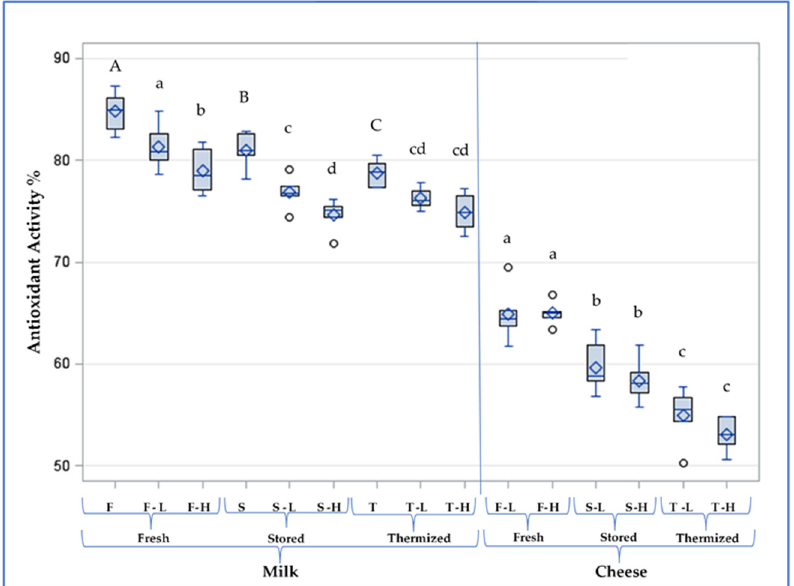
Figure 6. Comparison of antioxidant activity in milk before pasteurization and after low and high pasteurization, and in the corresponding cheese made from each type of milk. Different letters indicate significant differences ( p < 0.05) within the group of milk or cheese. For the milk group, different capital letters were used in milk before pasteurization (F, S, and T) while lowercase letters in milk after pasteurization (F-L, F-H, S-L, S-H, T-L, T-H). Milk before pasteurization: F = fresh milk, S = stored milk, T = thermized milk. Milk after pasteurization: L = low pasteurization (72 °C for 15 s), H = high pasteurization (77 °C for 15 s).